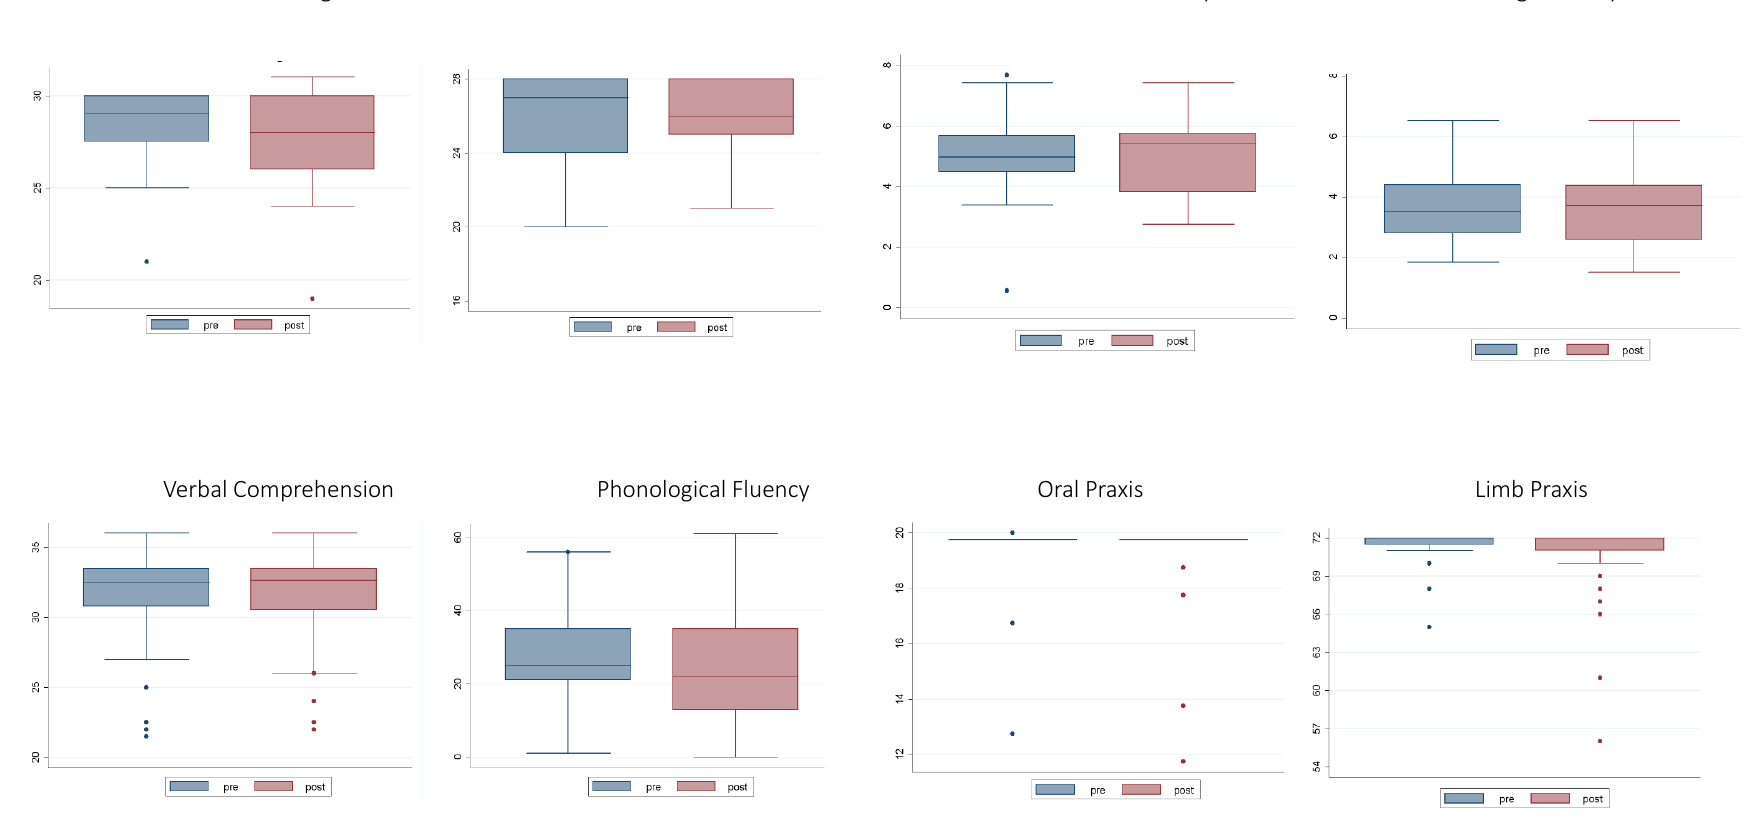
Figure 4. Mean performance of the 40 patients with recurrent glioma T3 and T4 (pre- and post-recurrence surgery, respectively). Bars represent the standard